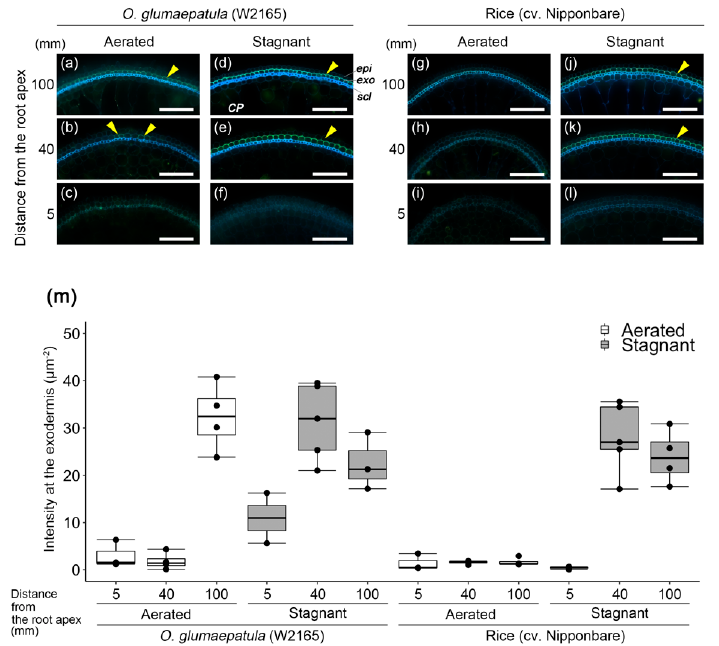
Figure 2. Suberization in the outer part of roots in accession W2165 of O. glumaepatula and rice (cv. Nipponbare) under aerated or stagnant conditions. Suberin lamellae were observed in the basal parts (95–105 mm from the root apex; a , d , g , j ), middle parts (35–45 mm from the root apex; b , e , h , k ) and root tips (2.5–7.5 mm from the root apex; c , f , i , l ) of adventitious roots of 115–120 mm length. Suberin lamellae are indicated as yellow-green fluorescence with Fluorol Yellow 088 (yellow arrowhead, mean of intensity value >20.0 μ m − 2 ). Blue fluorescence indicates autofluorescence. Plants were grown in aerated nutrient solution for eight days and then transferred to deoxygenated stagnant 0.1% agar solution or continued aerated solution for 13–15 days. CP , cortical parenchyma; epi , epidermis; exo , exodermis; scl , sclerenchyma. Scale bars: 100 μ m. ( m ) Fluorescence intensity of Fluorol Yellow 088 at the exodermis under aerated (white box) or stagnant (grey box) conditions. Black dots indicate each raw value. n = 2–5.